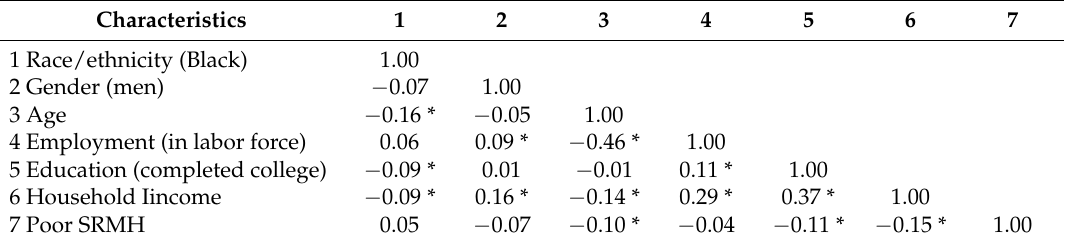
Table 2. Spearman correlations in the pooled sample and by race.